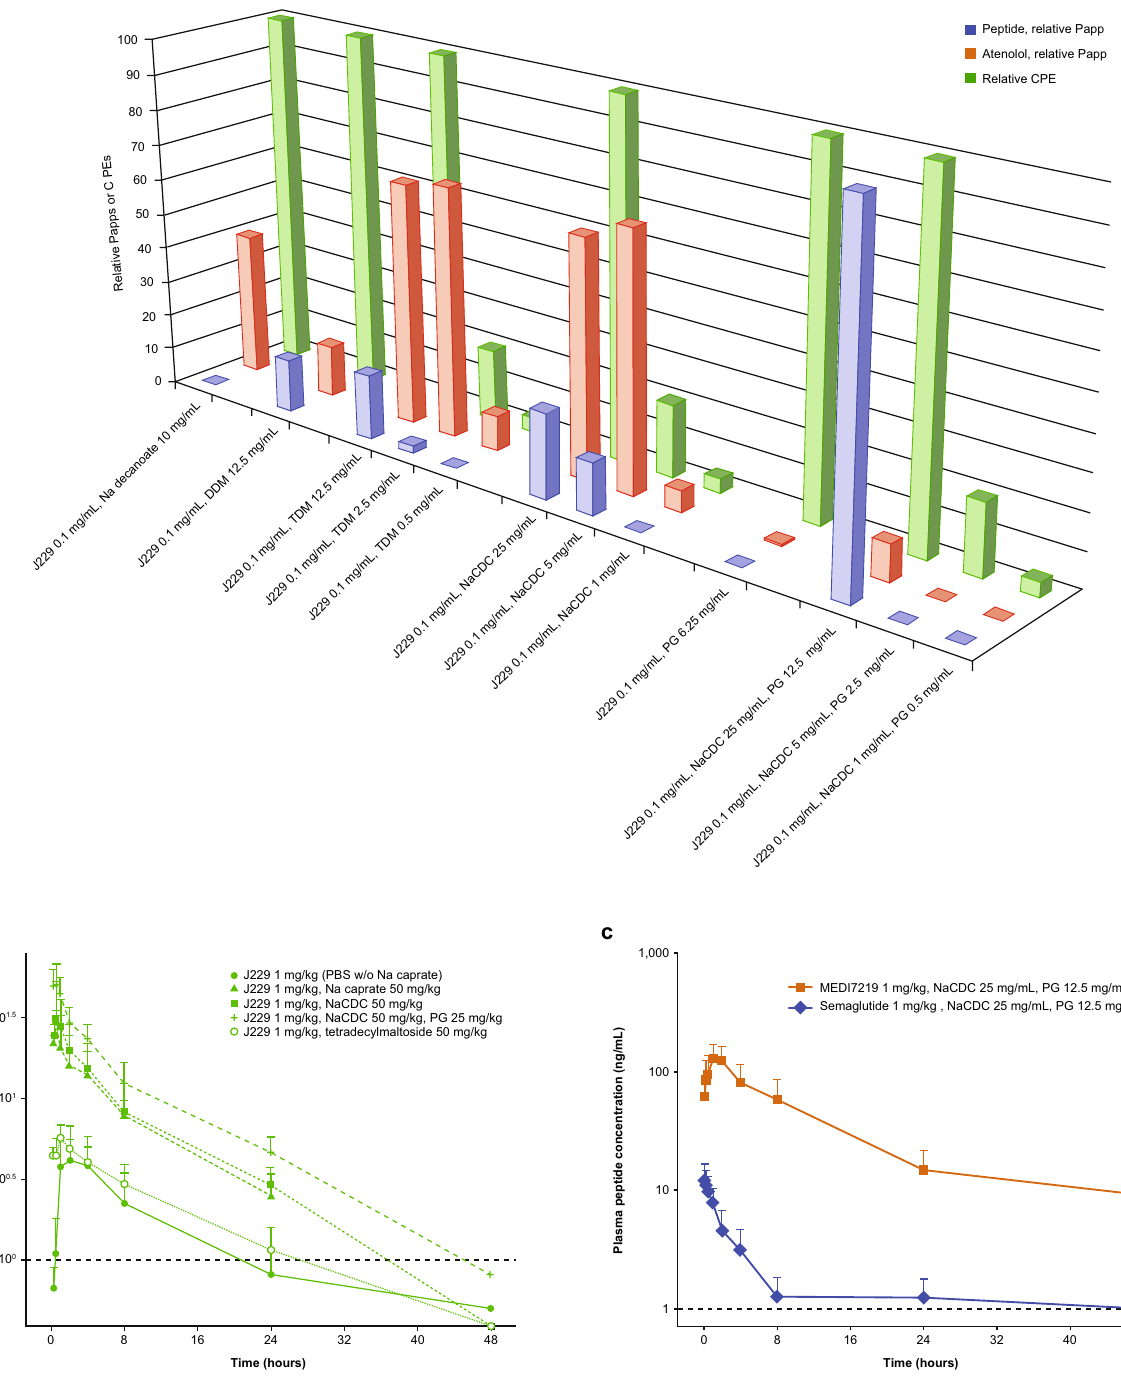
Figure 4. Oral tablet formulation development of GLP-1RAs. ( a ) Caco-2 screen for selection of permeation enhancers showing relative permeability coefficient of J229 (blue bars) compared with reference compound atenolol (orange bars) across Caco-2 monolayer in the presence of different permeation enhancers. Relative permeability expressed as percentage of highest observed apparent permeability coefficient (Papp; 43.1 × 10 –6 cm s -1 ) of J229 0.1 mg/mL with NaCDC 25 mg/mL and PG 12.5 mg/mL. Green bars show relative concentration of permeation enhancers (CPE). ( b ) Mean plasma concentration–time profiles of J229 1 mg/kg in rats following single intraduodenal administration with permeation enhancers. ( c ) Mean plasma concentration– time profiles of MEDI7219 and semaglutide in rats following single intraduodenal administration of MEDI7219 with sodium chenodeoxycholate (NaCDC) and propyl gallate (PG) as permeation enhancers. Values are presented as mean and error bars represent standard error of mean (n = 4 per group). Lower limit of quantification (LLOQ; dotted line) is 1